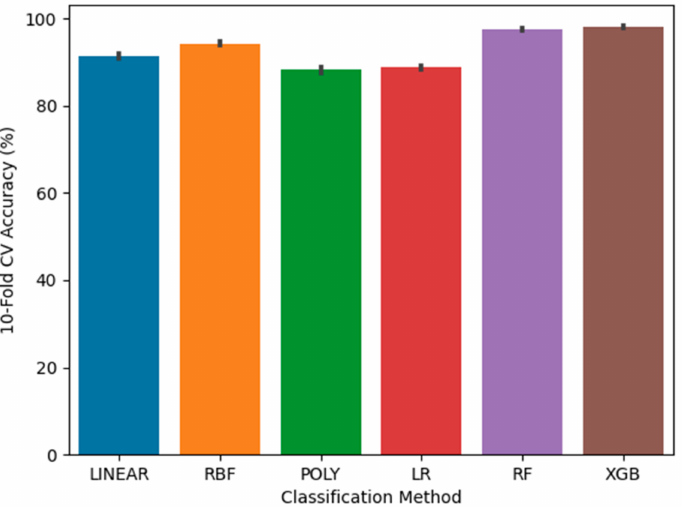
Figure 16. 10-fold CV accuracy for default classification methods (Case